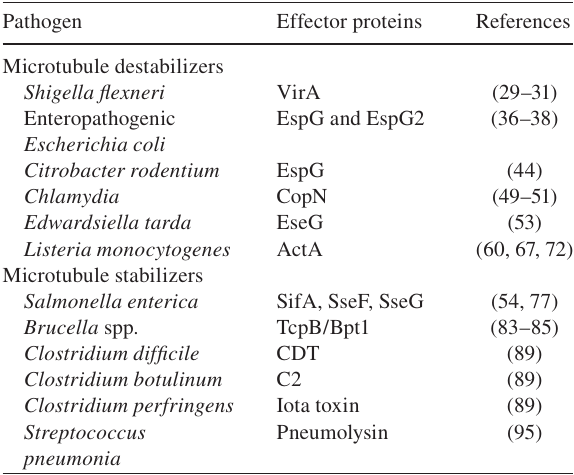
Table 1 Bacterial effector proteins that modulate microtubule dynamics.